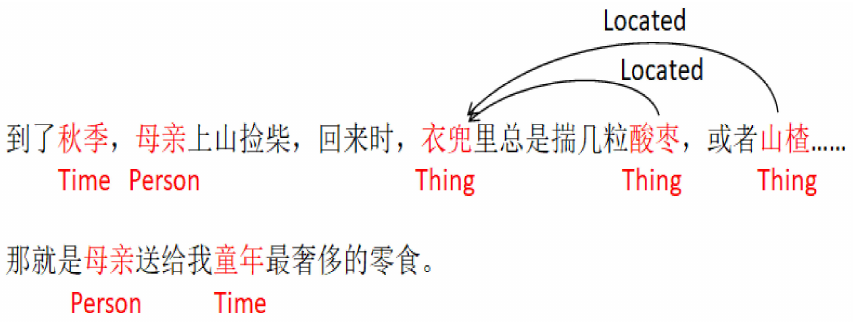
Figure 1. Example from the Chinese literature text